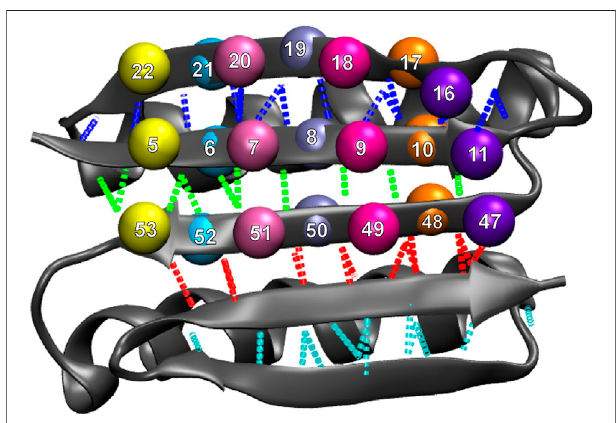
FIGURE 7 | Residues involved in the fi rst and second set ( Figure 1 ) of hydrogen bonds and corresponding residue triplets used for the angle analysis(seeMethodssection).Thecolorsofthehydrogenbondscorrespond to those in Figure 1B , and the colors oftriplets involving residues 16 – 19 correspond to those in Figure 6D (triplets are represented by identically colored C α